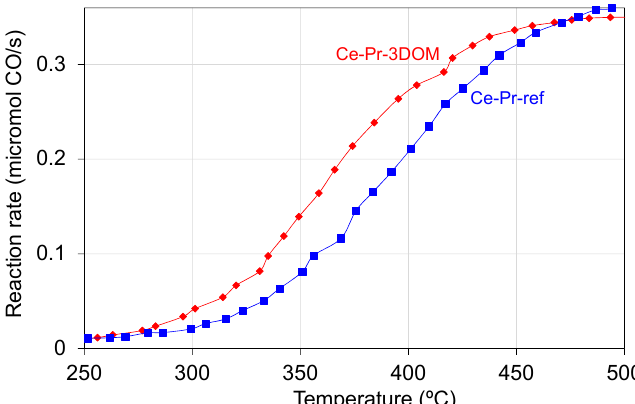
Figure 1. CO oxidation rate as a function of temperature for catalytic tests performed with Ce ‐ Pr ‐ 3DOM and Ce ‐ Pr ‐ ref. (Total gas flow 60 mL/min; 1% CO + 17% O 2 in N 2 ; 50 mg of catalyst).